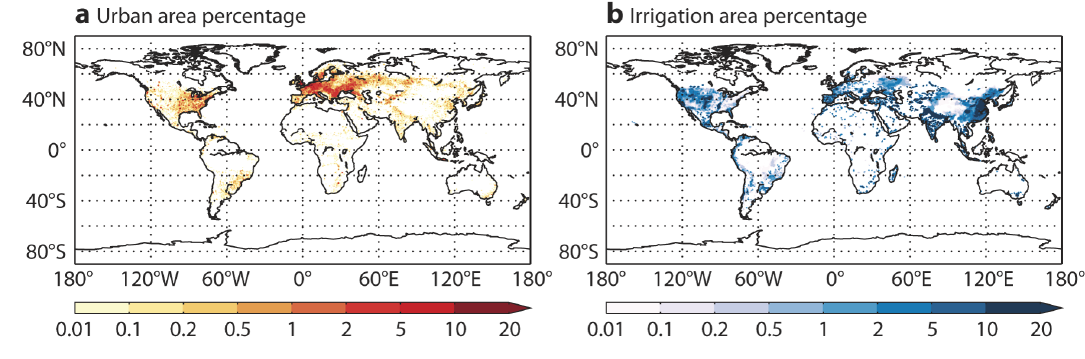
Figure 26. Urban areas and irrigated